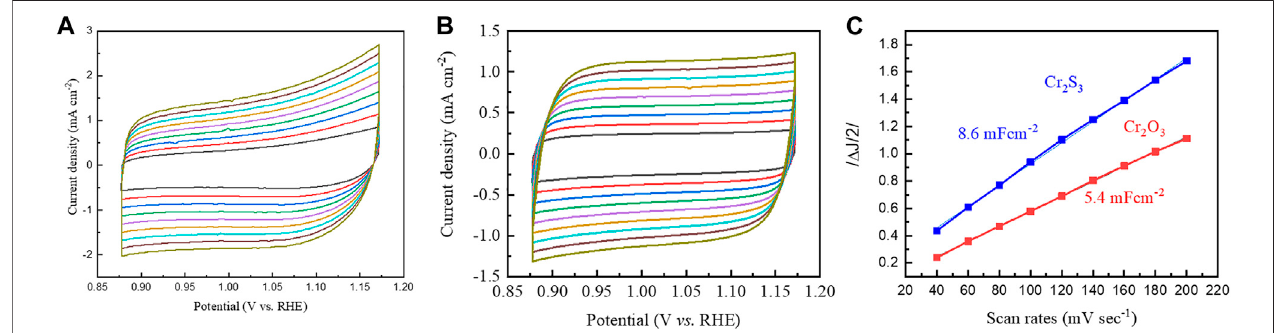
FIGURE 5 | Cyclic voltammetries of Cr 2 S 3 (A) and Cr 2 O 3 (B) made at various scan rates in the non-Faradaic region. (C) The current density as a function of scan rate curves derived from (A) and (B)